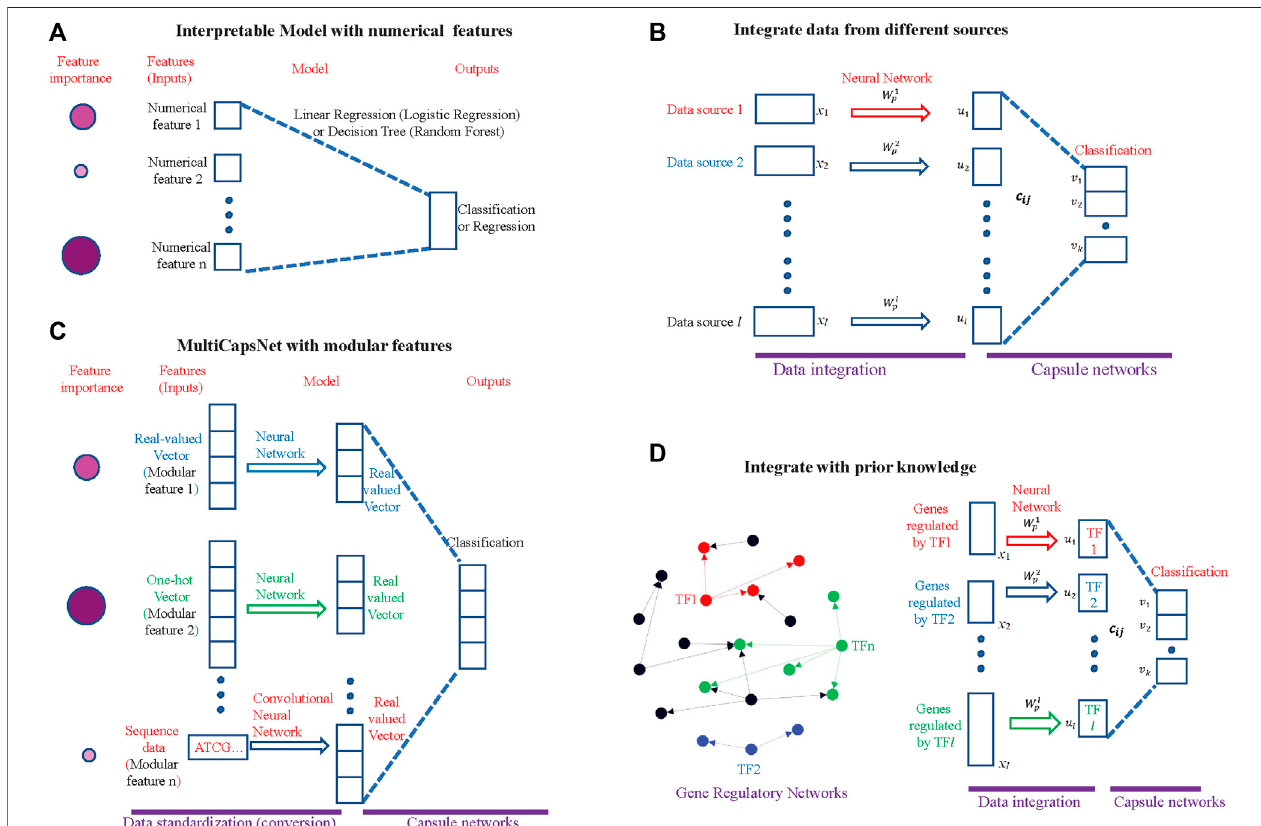
FIGURE1| MultiCapsNetisaninterpretableclassi fi eranddataintegratorwithmodularinputs .(A) Thetraditionalinterpretablemachinelearningmethods.Theinput of this model is numerical. After training, the model will reveal the inputs (features) importance for classi fi cation (or regression). The size and color depth of the circle indicate the importance of the features, while the larger and darker circle indicates that the feature is more important. (B) The MultiCapsNet is an interpretable classi fi er with modular input. The inputs (features) with different format (real-valued vector, one-hot encoding vector, or sequence data) and different lengths are fi rst converted into real-valued vectors with equal length through trainable networks. Then, classi fi cation was based on those real-valued vectors of the same length. After training,themodelwillrevealtheinputs(features)importancetoclassi fi cation.Thesizeandcolordepthofthecircleindicatetheimportanceofthefeature,whilelargerand darker circle indicates that the feature is more important. (C) The MultiCapsNet could integrate data from different sources. (D) The MultiCapsNet could integrate prior knowledge, such as gene regulatory information. Left: Gene regulatory networks, transcription factor and its targets are marked with same color. Right: expression of genes that are regulated by the same transcription factor could be regarded as a data